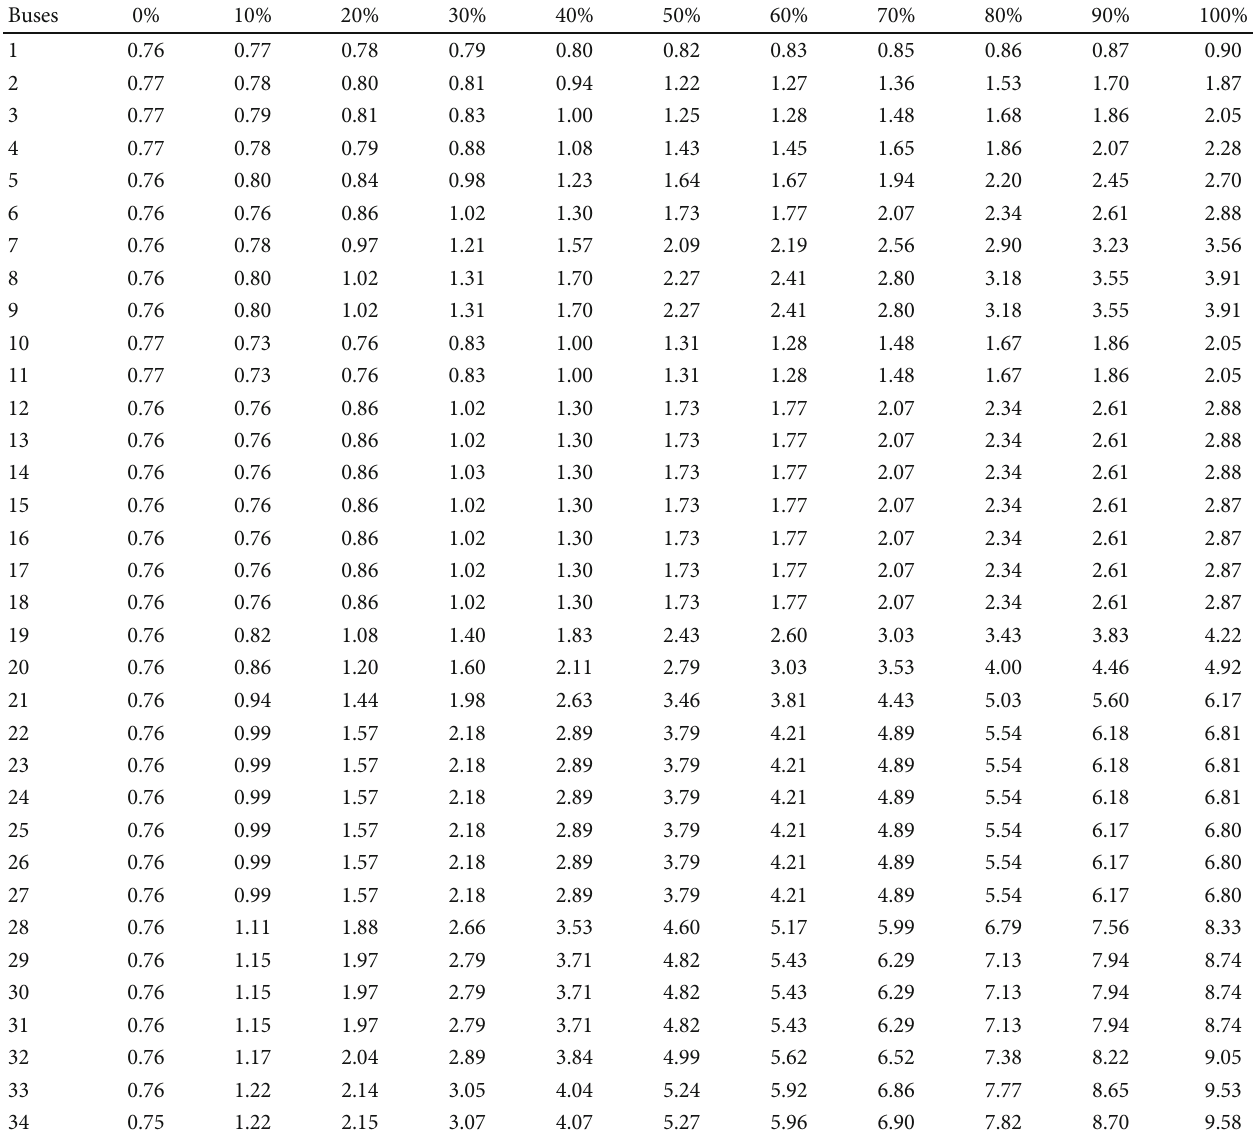
Table 6: Voltage THD at each bus for di ff erent PV penetration